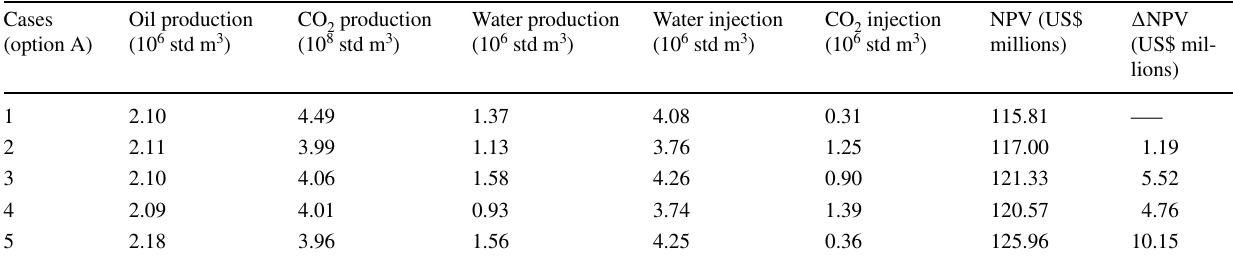
Table 14 Comparison between results of option A Cases (option A)